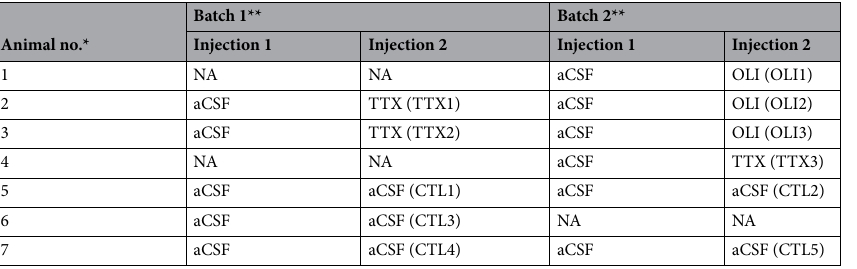
Table 1. Detailed description of hyperpolarized [1- 13 C]pyruvate injections and the experimental groups. *The animal number corresponds to the chronological order of the experiments. **Batch 1 and Batch 2 were obtained from the same animal. Batch 2 was investigated after Batch 1. NA: Data excluded due to technical difficulties during the experiment. aCSF, no pharmacological challenge. TTX, cerebrum slices incubated with tetrodotoxin; OLI, cerebrum slices incubated with oligomycin. The identifiers TTX1-3, OLI1-3, and CTL1-5 correspond with the data presented in Tables S1 and S2 in the supporting